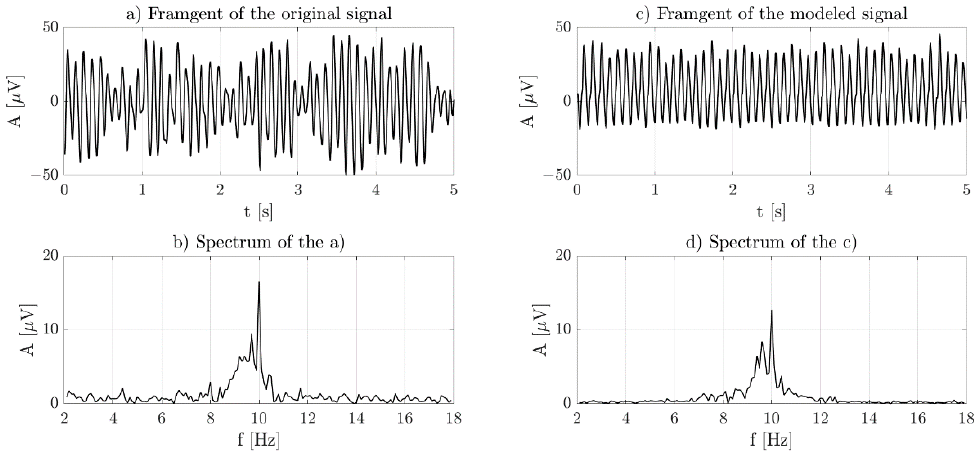
Figure 7. Visual illustration of optimal parameters—comparison of the modeled and real signals.